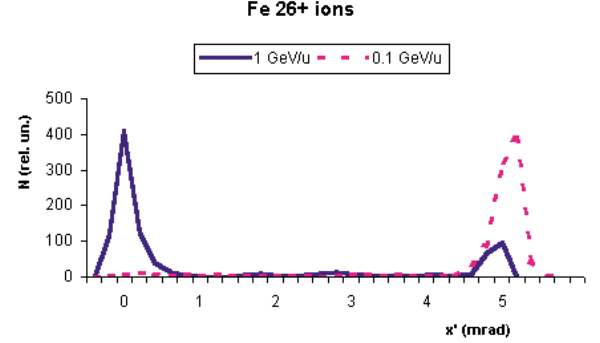
FIG. 4. (Color) The angular distribution of Fe (cid:1) 26 ions down- stream of the bent nanotube, shown for two